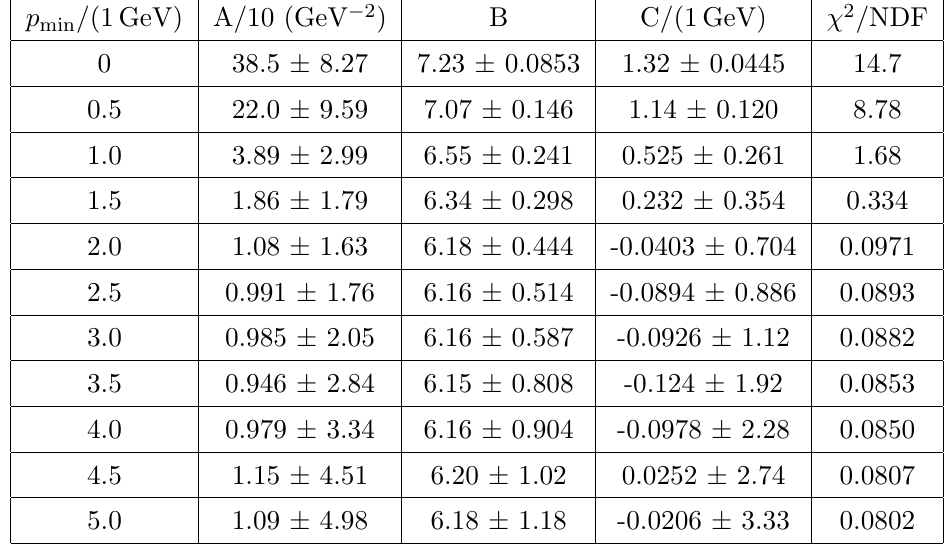
Table 7. Fitted values of parameters in eq. (E.3) for the ALICE dataset at p s = 5 : 02 TeV in the (cid:17) < 0 : 3 bin j j